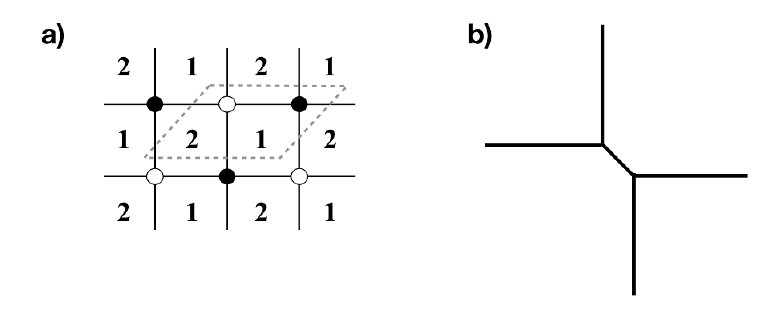
Figure 1 . (a) Dimer diagram for the theory of D-branes at a conifold. The dashed line is the unit cell in the periodic array. (b) Web diagram of the conifold. We have displayed it with a (cid:12)nite size S 2 (middle segment) for clarity; the actual singularity arises when this S 2 is